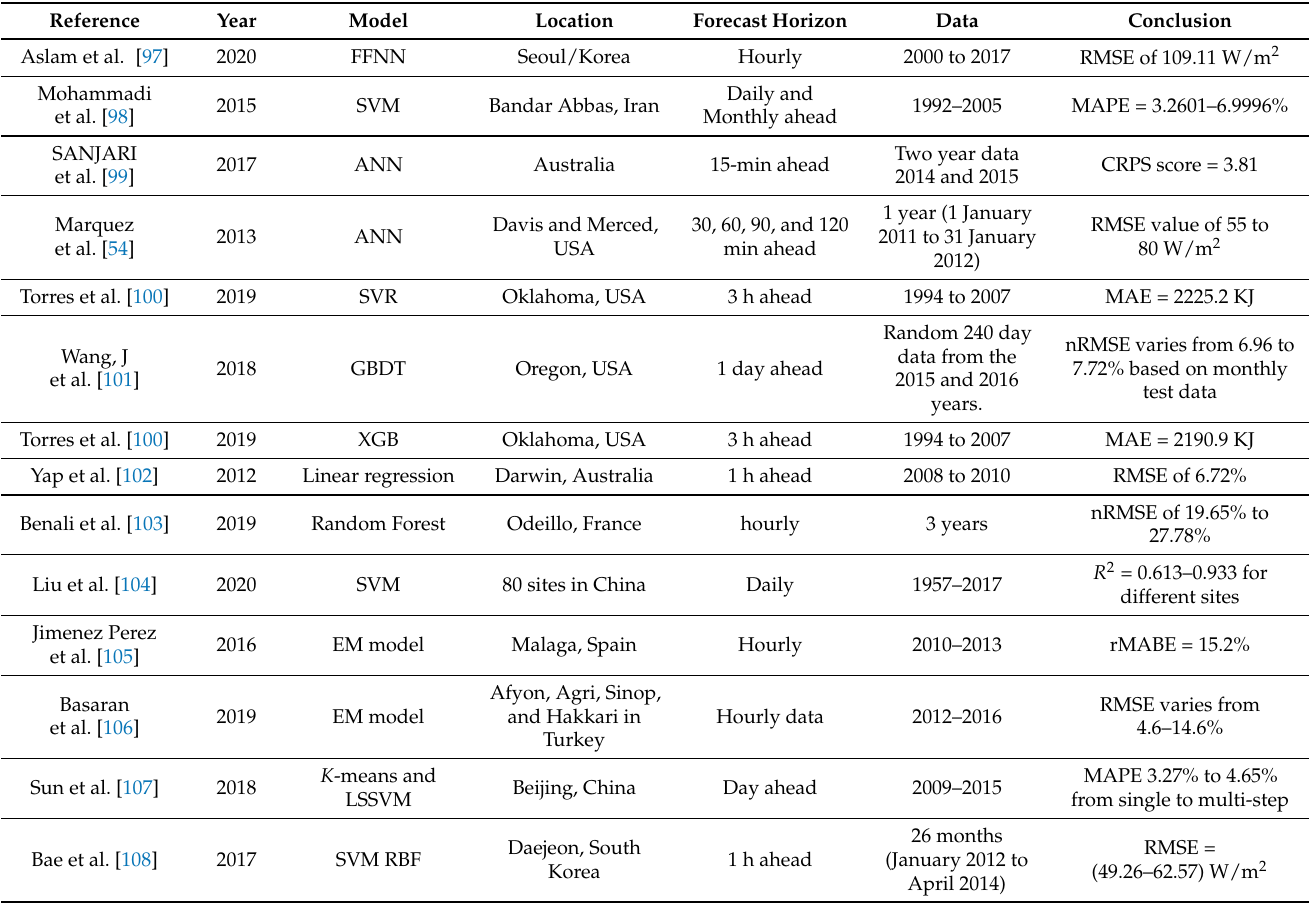
Table 6. Summary of machine learning